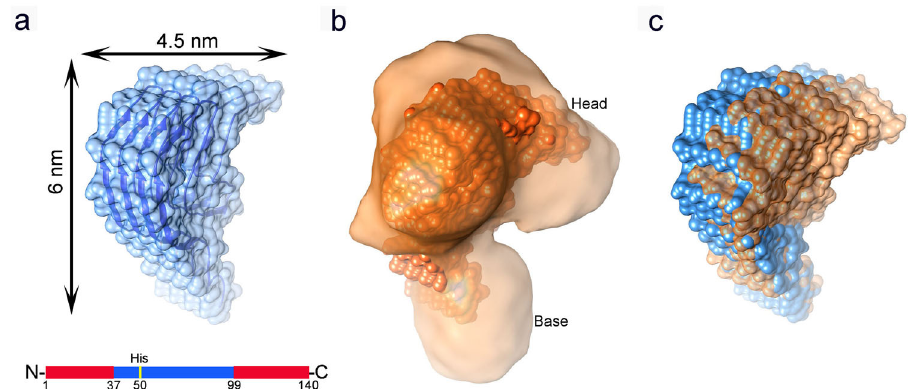
Fig. 6 Structural characterization of the molecular mace density map. a A representation of four α -Syn chains arranged as per the Greek-key architecture ( PDB 2N0A ) in cartoon representation (blue) inside the semi-transparent surface. Only the structured part (residue 37 – 99) is shown and the unstructured regions (residues 1 – 36 and 100 – 140, shown below) are not included in the structure. b The full structure shown in fi gure A could not be fi tted into the density map of oligomer 1 as a rigid piece. The ‘ head ’ and ‘ base ’ parts of fi gure A was fi tted separately (orange CPK sphere representations) into the density map of oligomer 1 generated from oligomers 1 (semi-transparent orange). c Superimposition of the Greek-key structure from panel a (in blue) and the fi tted model from panel b (in orange) represented in spheres, shows distortion in the fi tted model near its ‘ head ’–‘ base ’